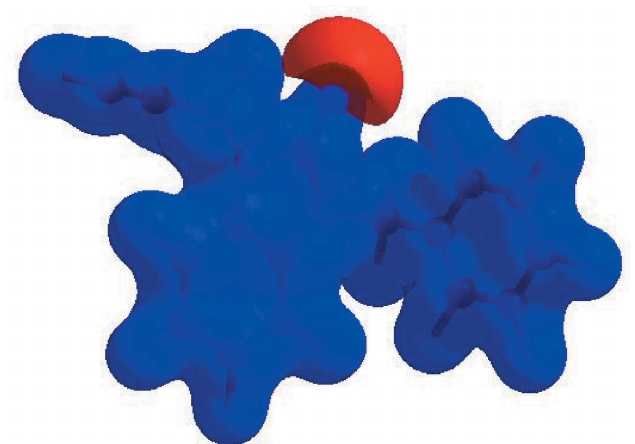
Figure 5 View of the three-dimensional Hirshfeld surface of the title compound plotted over electrostatic potential energy in the range (cid:4) 0.0500 to 0.0500 a.u. using the STO-3 G basis set at the Hartree–Fock level of theory hydrogen-bond donors and acceptors are shown as blue and red regions around the atoms corresponding to positive and negative potentials, respectively.